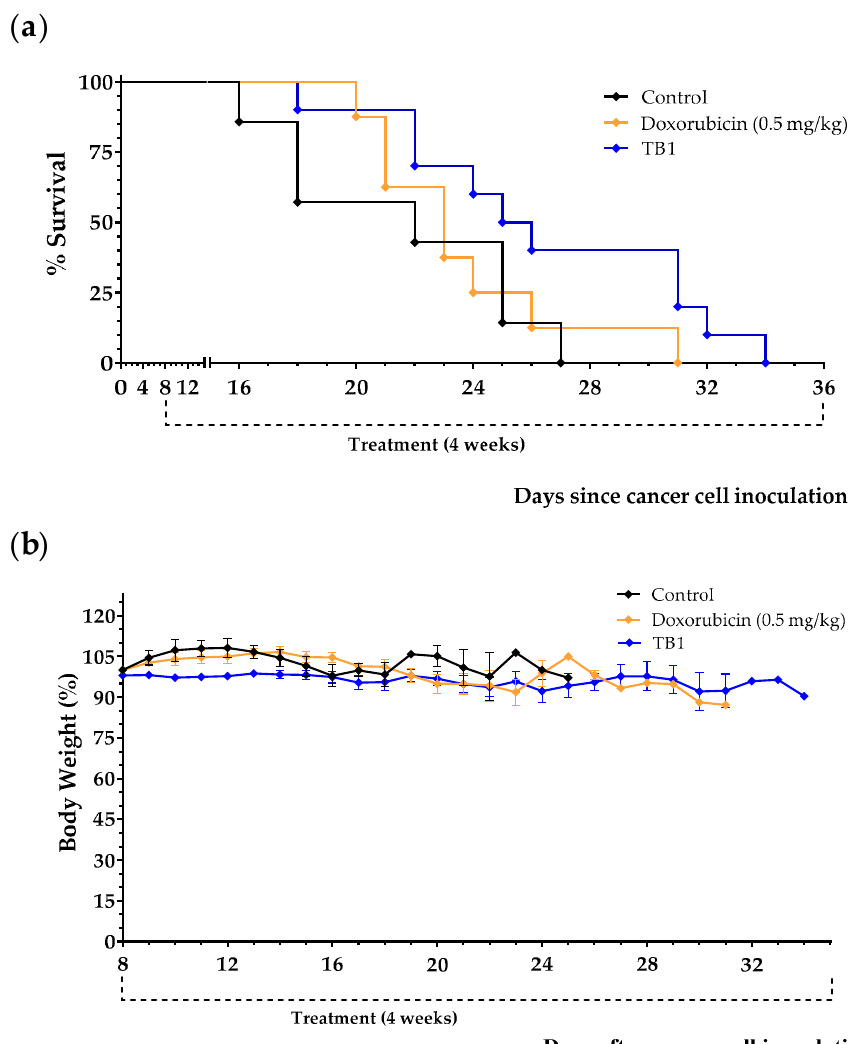
Data are from three independent experiments. The p -value was calculated with the Gehan–Breslow– Wilcoxon test. See text for further details.